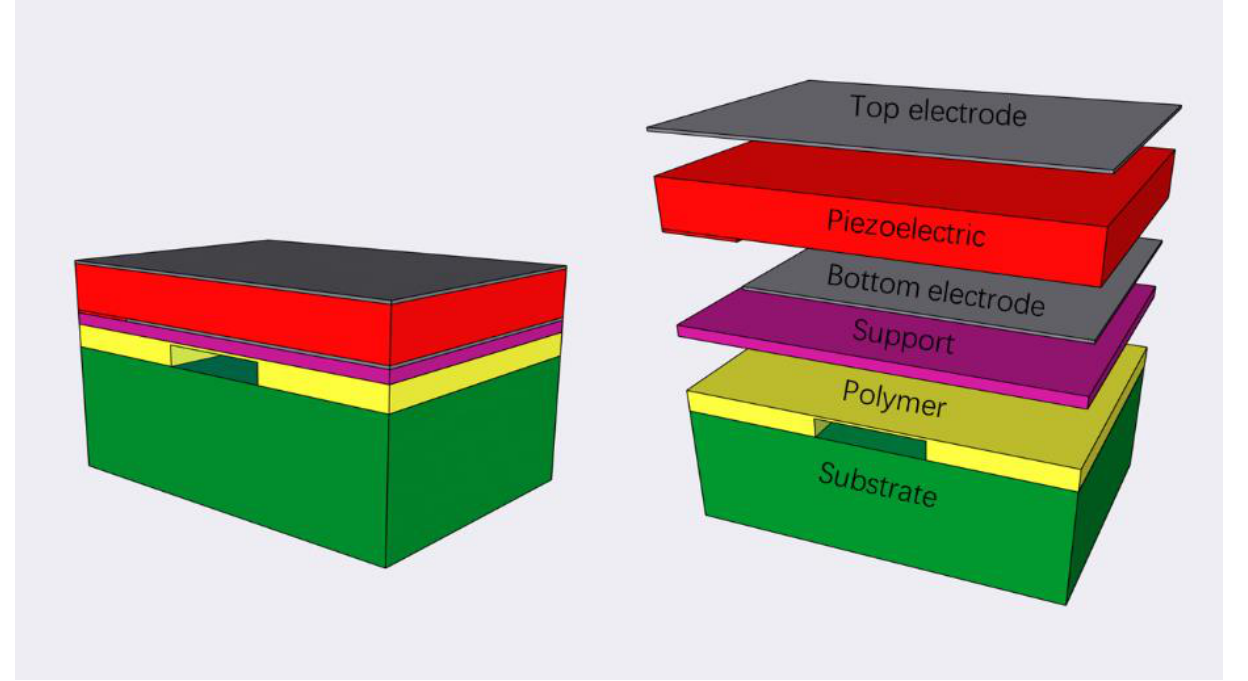
Figure 1. 3D model of the FBAR resonator.